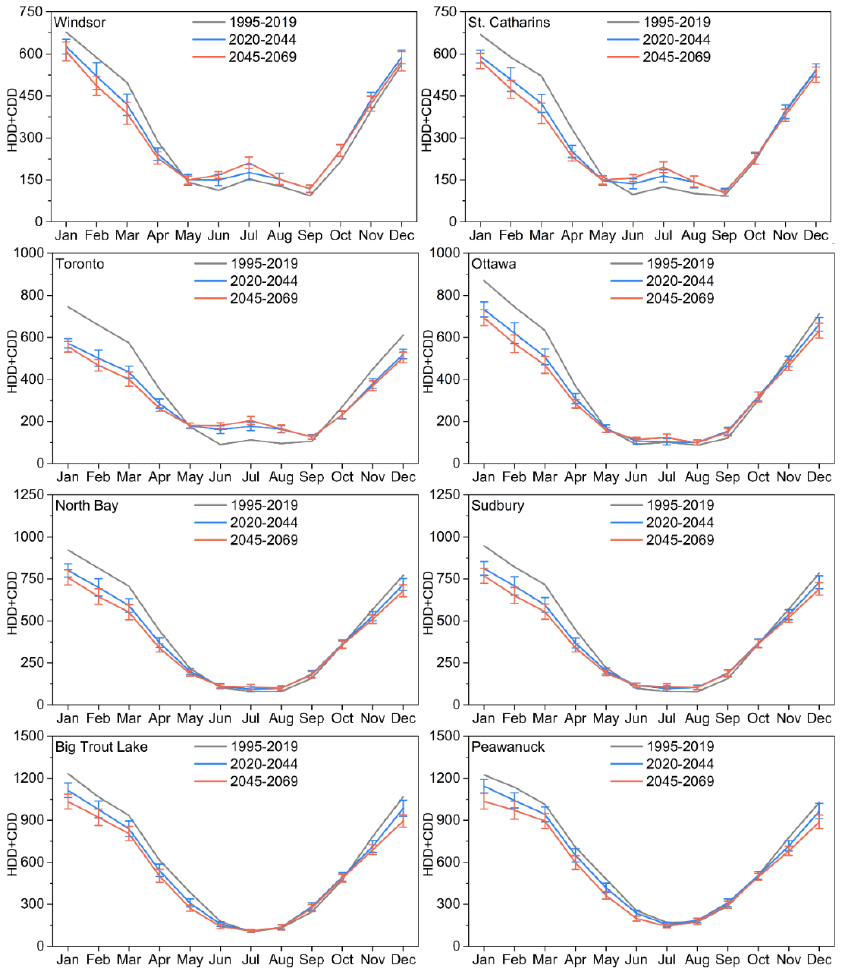
Figure 7. Historical (1995–2019) and future (2020–2069) monthly HDD + CDD for selected cities.